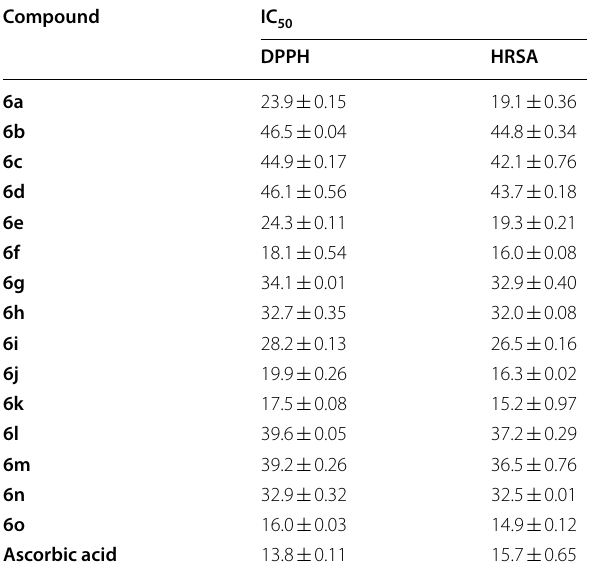
Table 2 IC values of 5 a – o Table 3 IC 50 values of 50